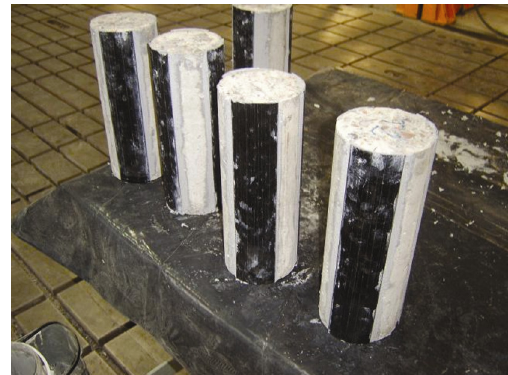
Fig. 12. Specimens preparation – stage II